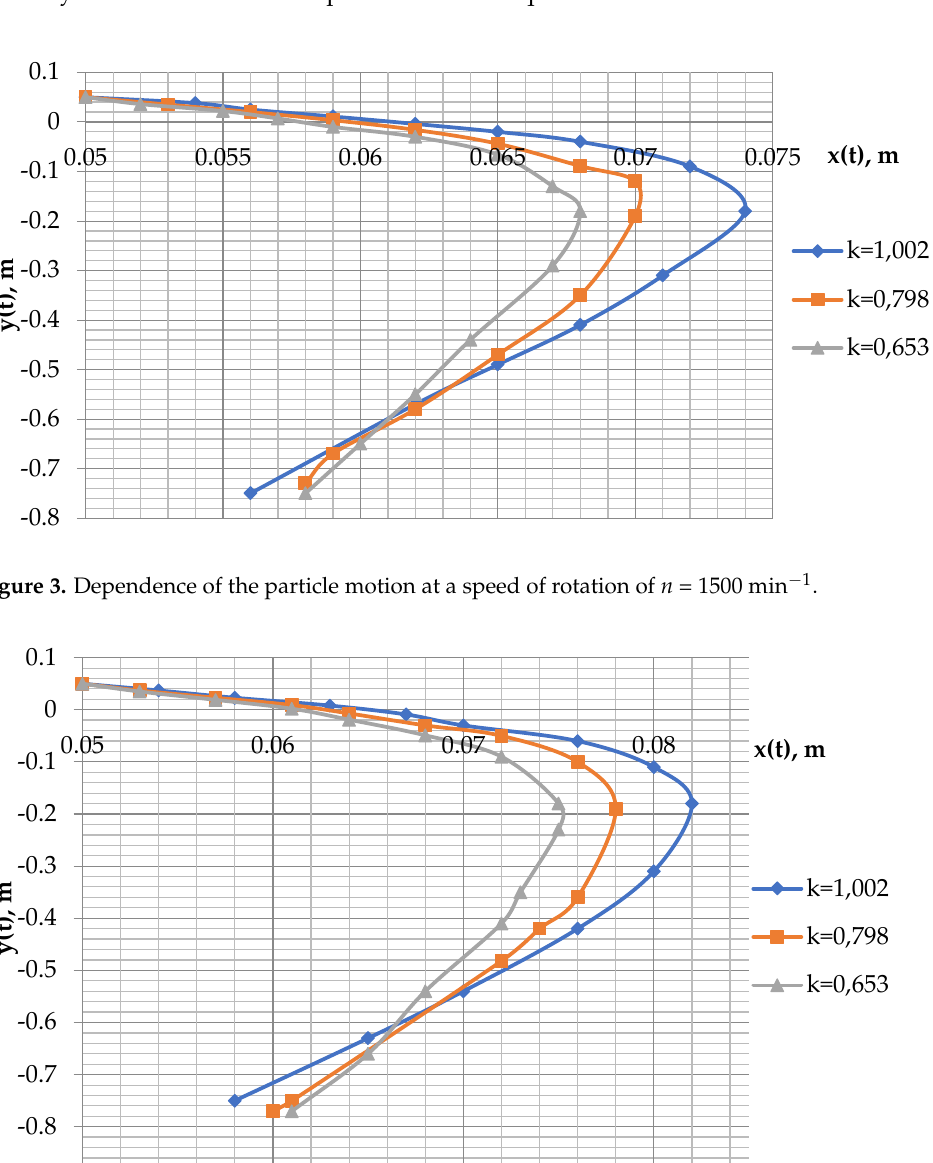
-0.9 Figure 4. Dependence of the particle motion at a rotation frequency of n = 2250 min − 1 .